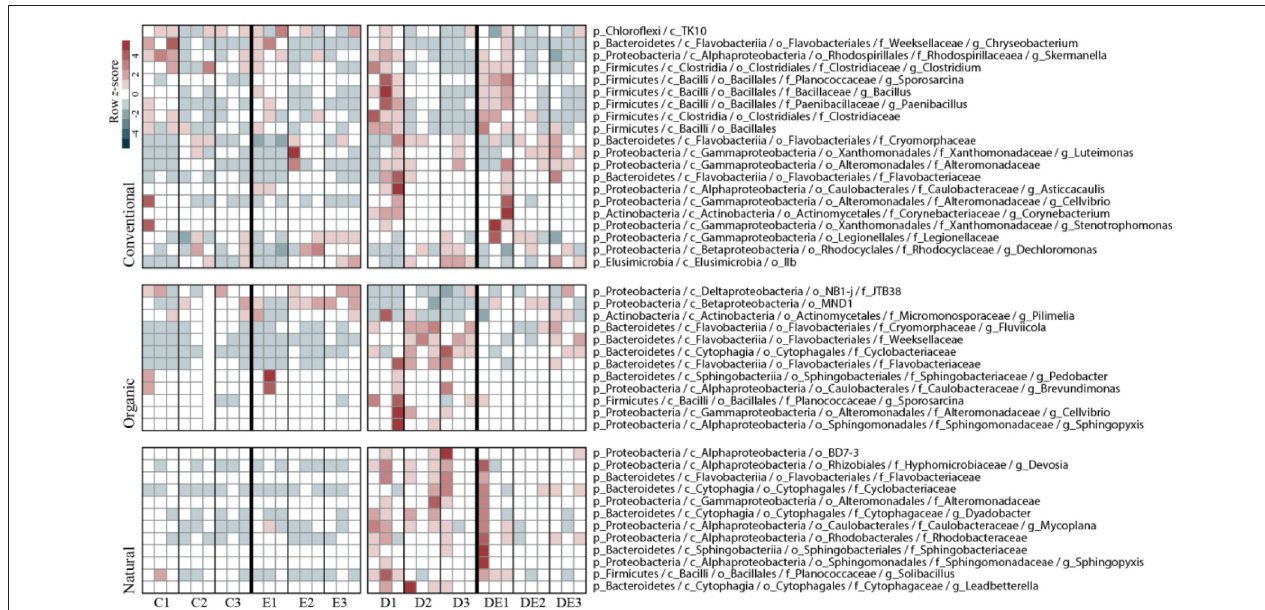
FIGURE 5 | Distribution of the differentially abundant bacterial taxa according to dung amendment for each soil management regime and sampling time. Taxa were identified by random forest analyses using Boruta feature selection (average z -scores of 1,000 runs > 4). Heat map displays relative abundance (column z -scores) of selected taxa by treatment at each sampled time point. C, Control; E, Earthworms; D, Dung; DE, Dung +